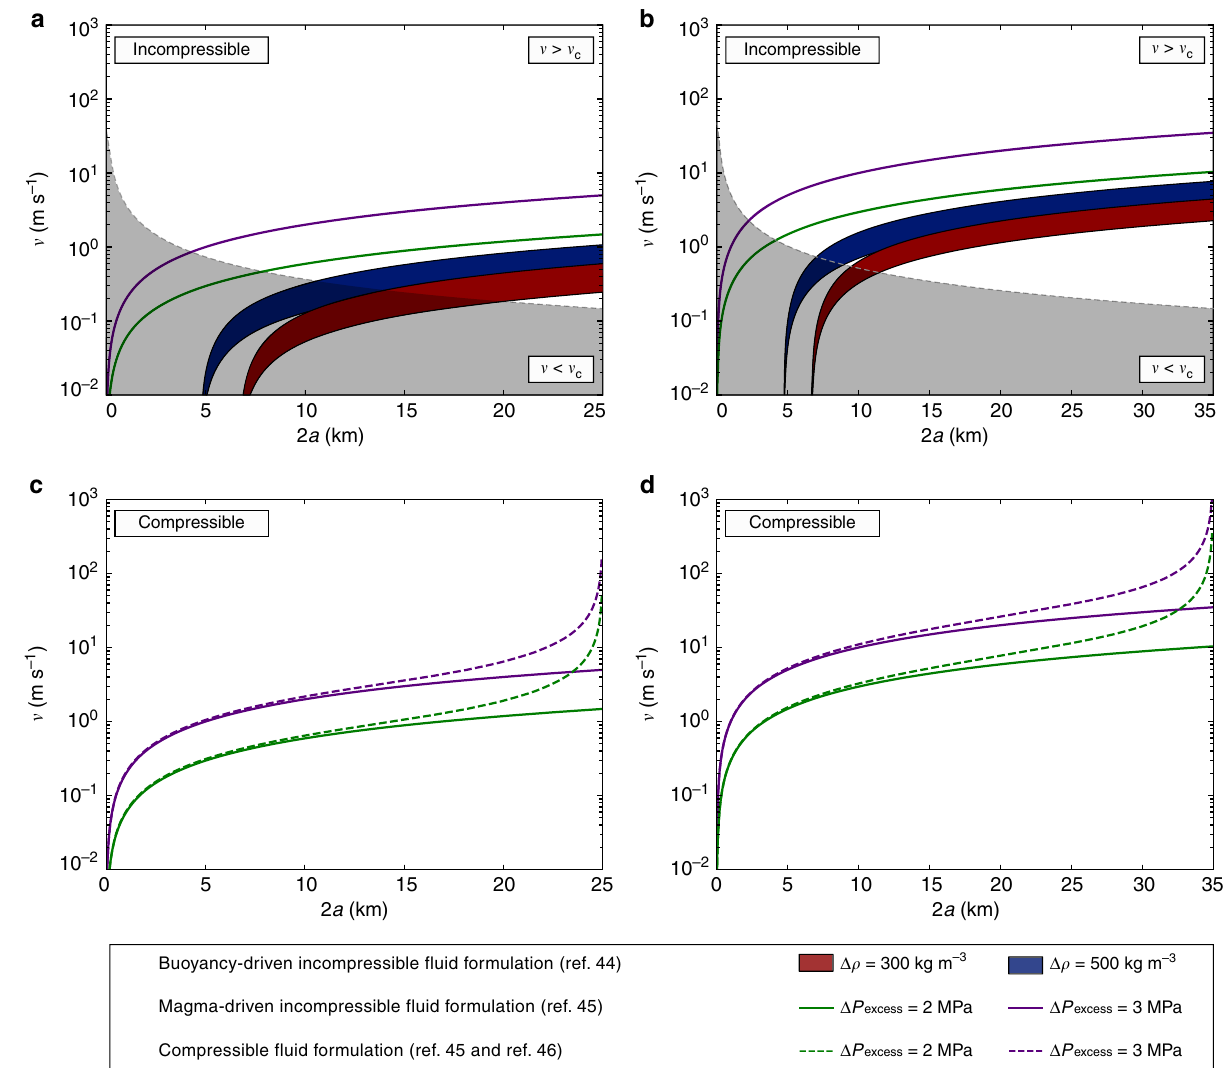
Fig. 6 Melt migration velocity. Migration velocities of the water-rich melts in a dike rising from 25 km ( a , c ) and 35 km ( b , d ). The melt is modeled utilizing the buoyancy-driven 43 and the magma-driven 45 formulation and assumed to behave as incompressible fl uid in a , b . The effect of volatile exsolution (compressible fl uid) on melt migration velocities has been modeled following Taisne and Jaupart 46 and reported in c ,